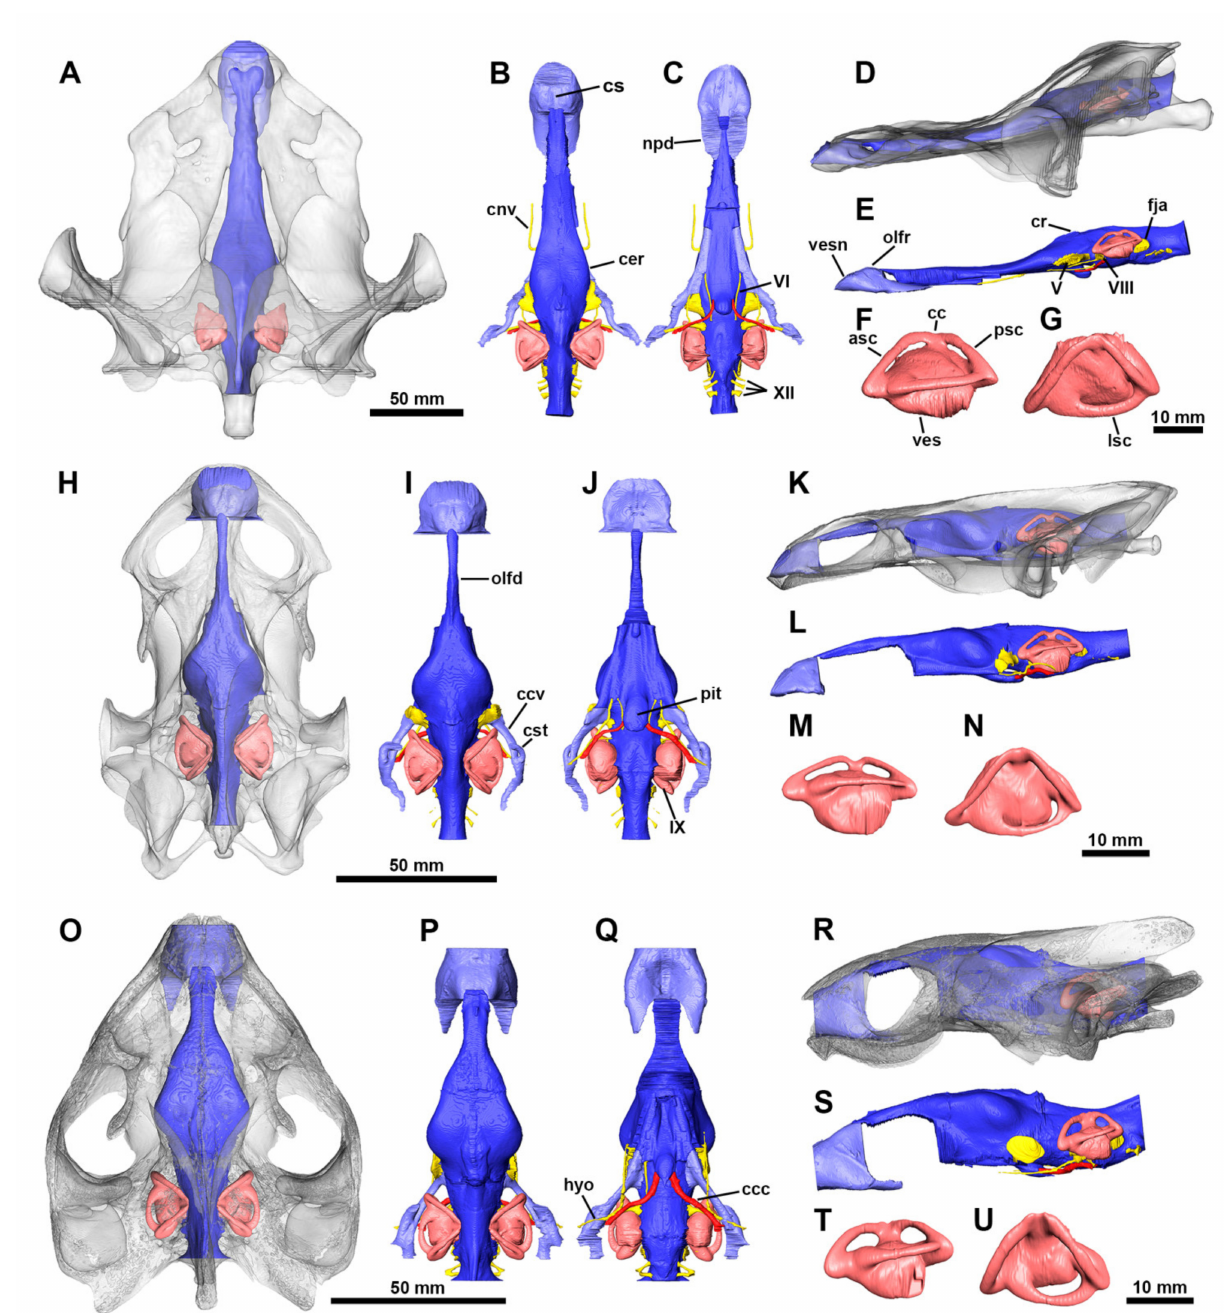
Figure 6. Osteological and neuroanatomical three-dimensional virtual reconstructions of the extant chelids Chelus fim- briata (MNHN.ZA.AC A9940; ( A – G )) and Hydromedusa tectifera (MNHN.ZA.AC 1870-9; ( H – N )), and the pelomedusid Pelusios niger (MNHN.ZA.AC 1934-371; ( O – U )). The osseous elements (in grey) have been visualized as transparent ( A , D , H , K , O , R ) in order to show the reconstruction of the endocast of cranial and nasal cavities (in blue), and inner ears (in pink) ( B , C , E , I , J , L , P , Q , S ). The reconstructions are presented in dorsal ( A , B , H , I , O , P ), ventral ( C , J , Q ), and left lateral ( D , E , K , L , R , S ) views. Reconstruction of the left inner ears of these taxa ( F , G , M , N , T , U ) in lateral ( F , M , T ) and dorsal ( G , N , U ) views. Abbreviations: asc, anterior semicircular canal; cc, crus communis; ccc, canalis caroticus cerebralis; ccv, canalis cavernosus; cer, cerebral hemisphere; cnv, canalis nervi vidiani; cprv, canalis pro ramo vidiani; cr, cartilaginous ridge; cs, cartilaginous septum; cst, canalis stapedio-temporalis; fja, foramen jugulare anterius; hyo, hyomandibular branch of facial nerve; ie, inner ear; IX, glossopharyngeal nerve; lsc, lateral semicircular canal; nc, nasal cavities; npd, nasopharyngeal duct; olfd, olfactory duct; olfr, olfactory region; pit, pituitary fossa; psc, posterior semicircular canal; V, trigeminal nerve; ves, vestibulum; vesn, vestibulum nasi; VI, abducens nerve; VII, facial nerve; VIII, vestibulocochlear nerve; XII, hypoglossal